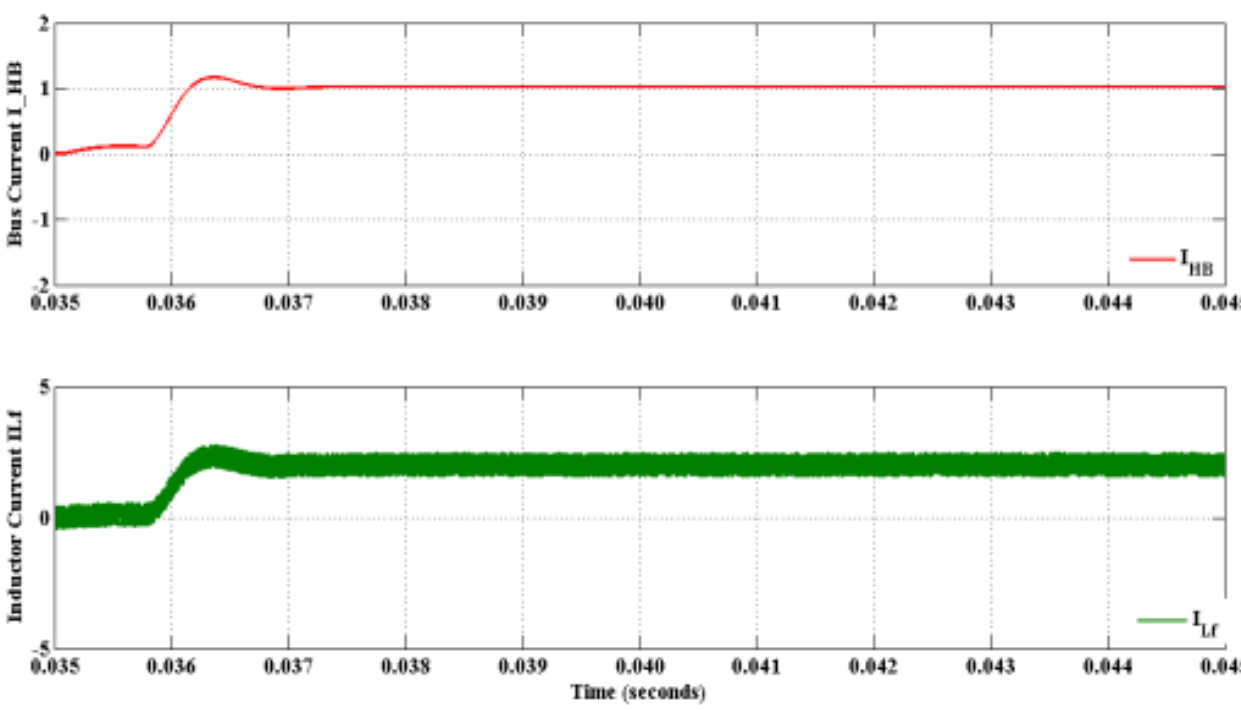
Figure 17. Gate signals, output voltage and inductor currents for boost mode.